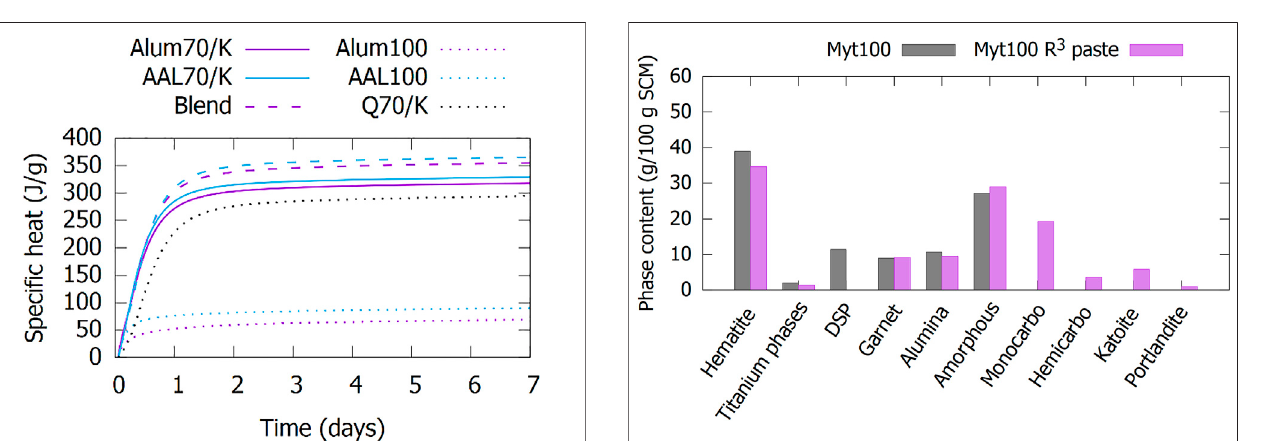
FIGURE 5 | Comparison between co-calcined BR and reference mixtures.